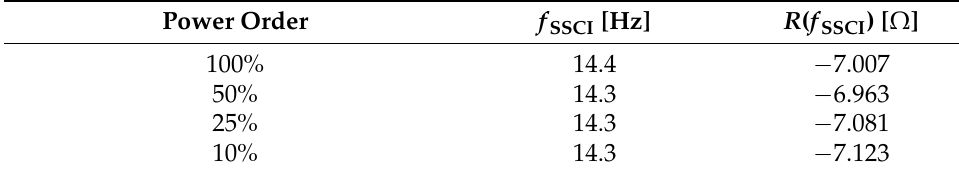
Table 4. Power order